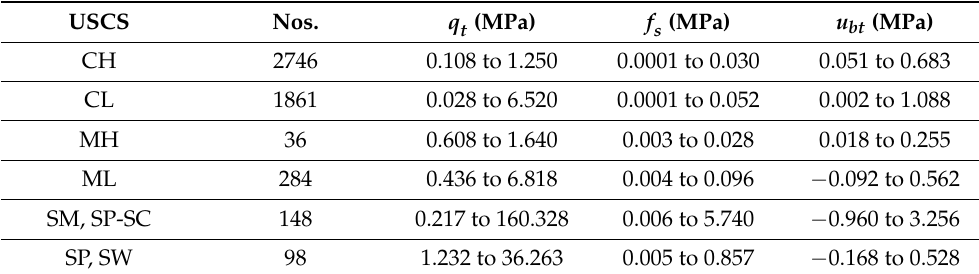
Table 2. Number of soil data points and corresponding PCPT data range. USCS